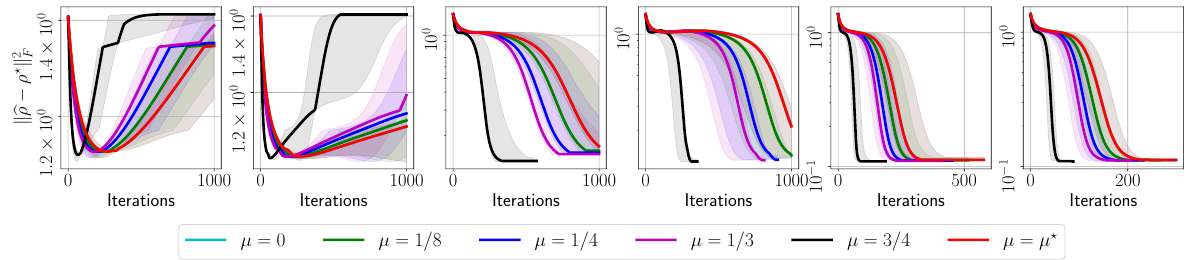
Figure A12. Fidelity list plots for reconstructing GHZ IBM Quantum system experiments and synthetic measurements from Qiskit simulation experiments.